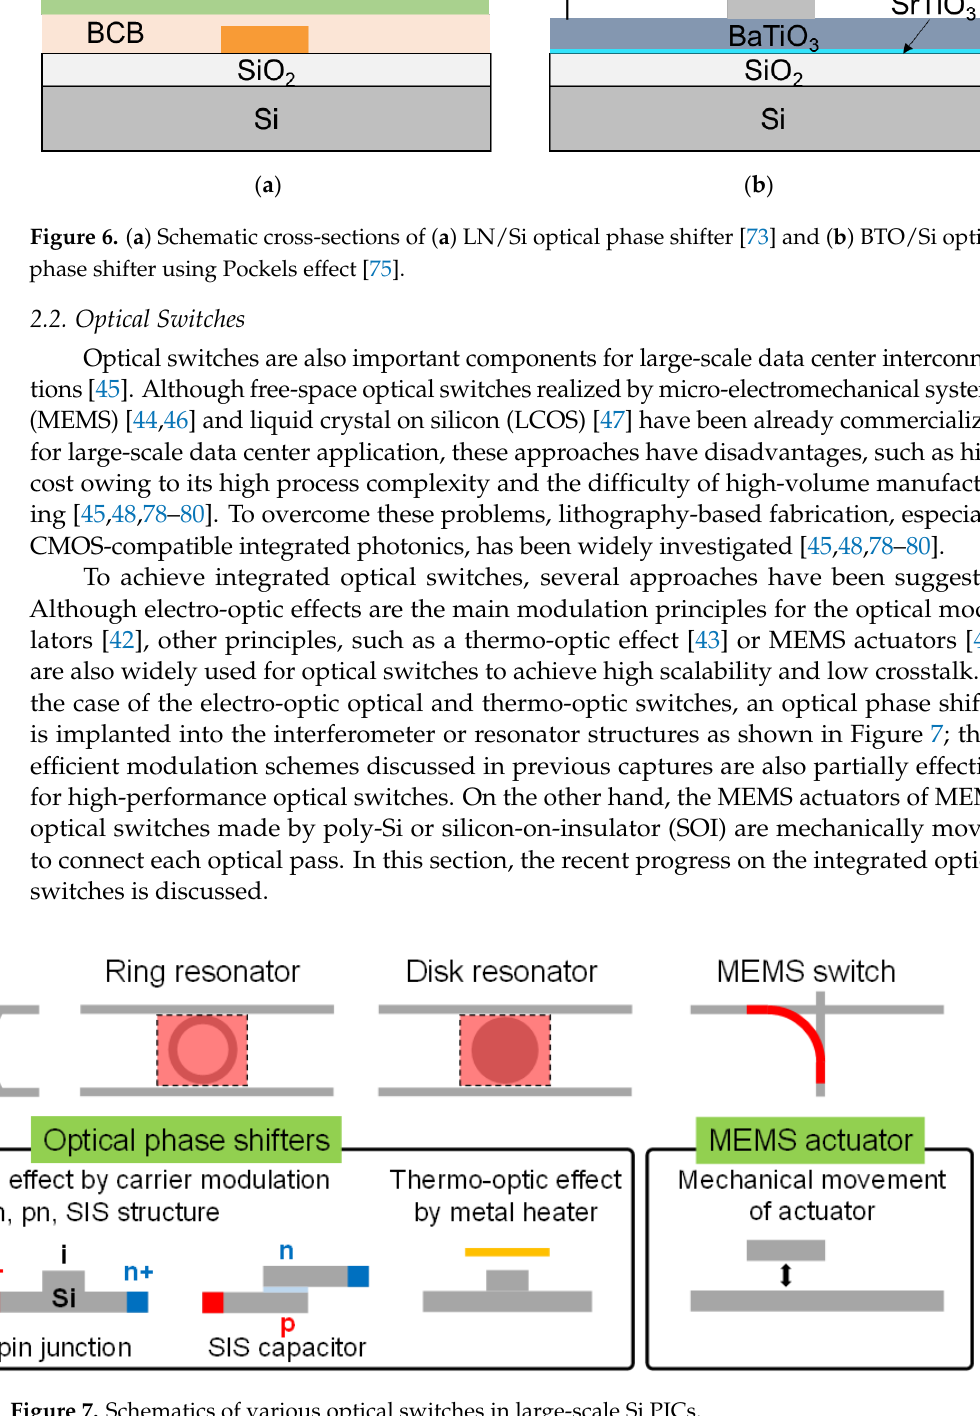
Figure 7. Schematics of various optical switches in large-scale Si